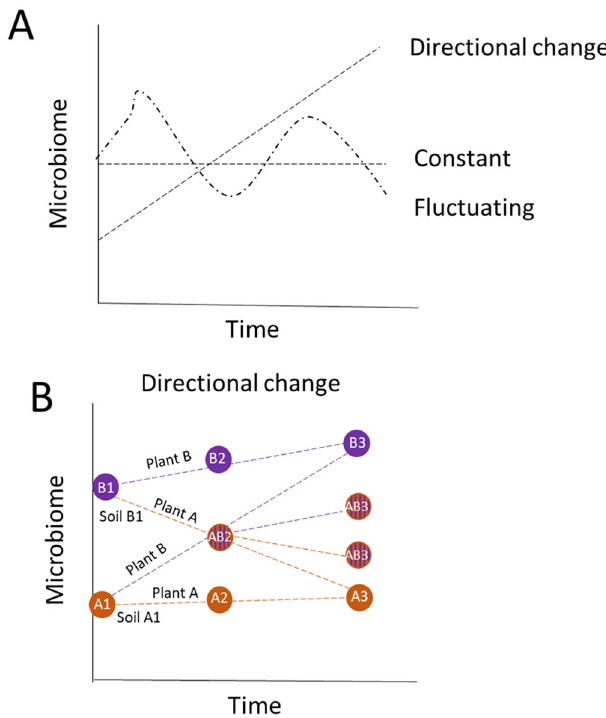
Fig. 2 Theoretical change in microbiomes over time. Theoretical framework of the effects of conditioning (previous) and responding (current) plants on soil microbial community composition. A we expect that the microbiome will change in time under a new plant community in either a directional, constant, or fl uctuating way. B Furthermore, if this change is directional, we expect that the change will lead to convergence in microbiomes and that over time the microbiome will develop into a species- speci fi c microbiome type but that this will depend on the initial microbiome composition and hence on the legacy of the plant that grew in the soil